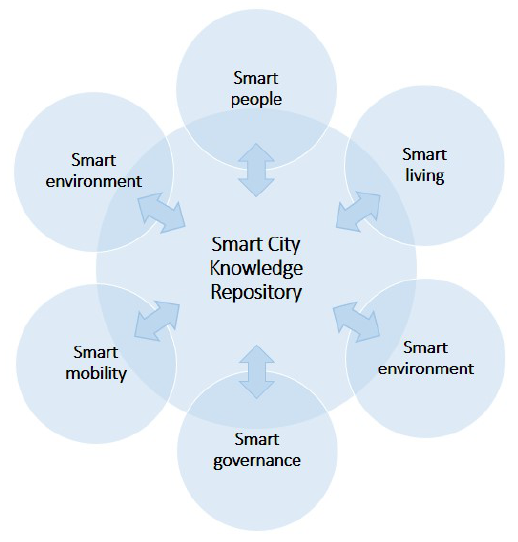
Figure 3. Smart city knowledge repository.